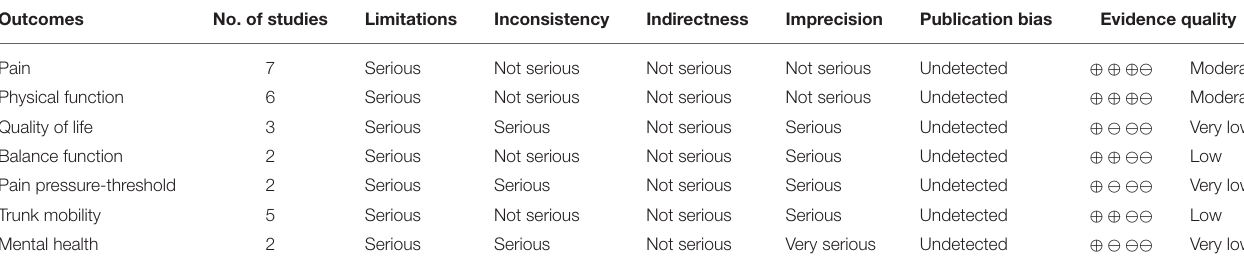
TABLE 3 | Evidence quality rated using the GRADE